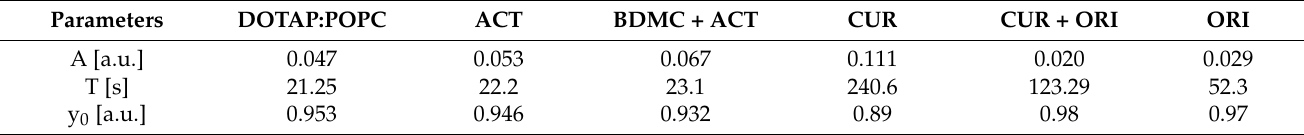
Table 3. Parameters determined in the L band EPR measurements for the liposomal formulations.